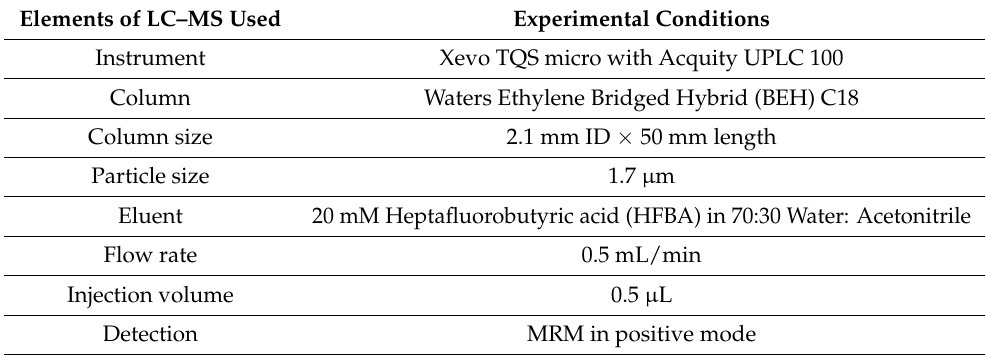
Table 1. Elements and experimental conditions of